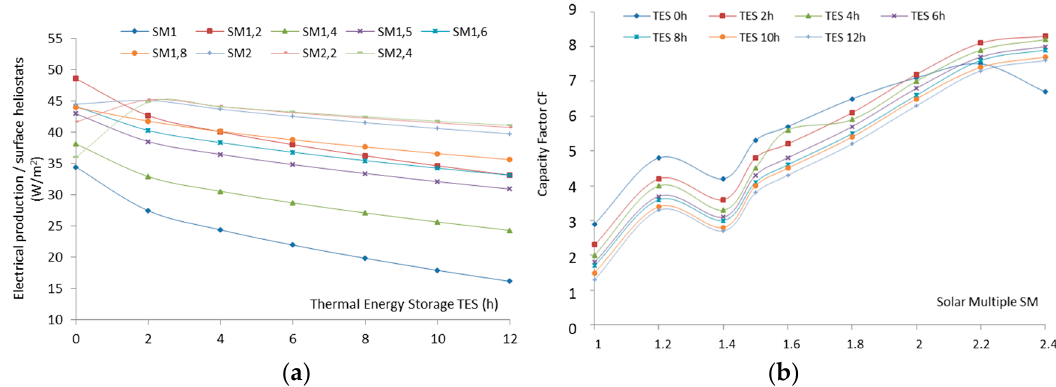
Figure 6. ( a ) The effect of Thermal Energy Storage ( TES) on electrical production/m 2 (surface heliostats) under different values of solar multiple. ( b ) The solar multiple effect on capacity factor ( CF ) under different TES values.